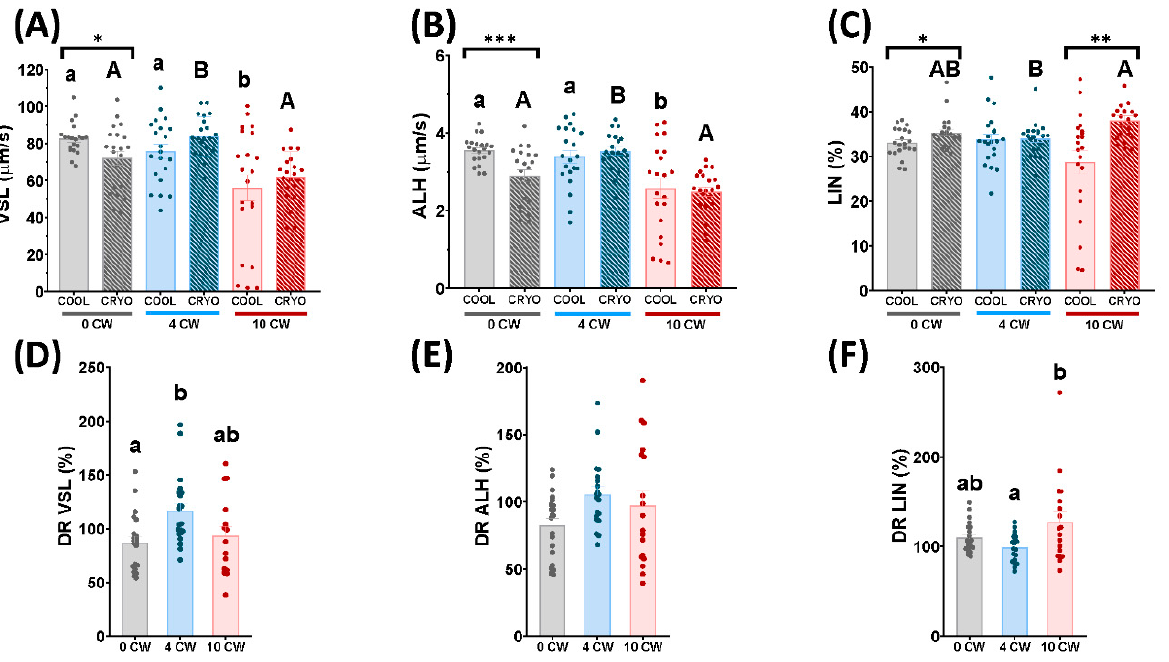
Figure 2. Ram sperm kinetics parameters in cooling (COOL) and frozen-thawed (CRYO) samples and differential rate (cooling/freezing) depending on the sperm collection frequency: without sperm collection (0 CW), 4 sperm collections per week (4 CW), 10 sperm collections per week (10 CW). ( A ) Velocity according to the straight path (VSL, µ m/s); ( B ) Amplitude of the lateral displacement of the sperm head (ALH, µ m); ( C ) Linearity (LIN, %); ( D ) Differential rate of velocity according to the straight path (VSL, %); ( E ) Differential rate of amplitude of the lateral displacement of the sperm head (ALH, %); ( F ) Differential rate of linearity (LIN, %). Significant differences ( p < 0.05) among experimental groups in cooling samples are represented with different lowercase superscripts letters (a, b). Significant differences ( p < 0.05) among experimental groups in frozen-thawed samples are represented with different capitals superscripts letters (A, B). Significant differences ( p < 0.05, p < 0.01, p < 0.001) between cooling and frozen-thawed samples in the same experimental group are represented with asterisks (*, **, ***, respectively). Significant differences ( p < 0.05) among the differential rate of the experimental groups are represented with different lowercase superscripts letters (a, b). The same twenty-one males were analyzed in each experimental group.